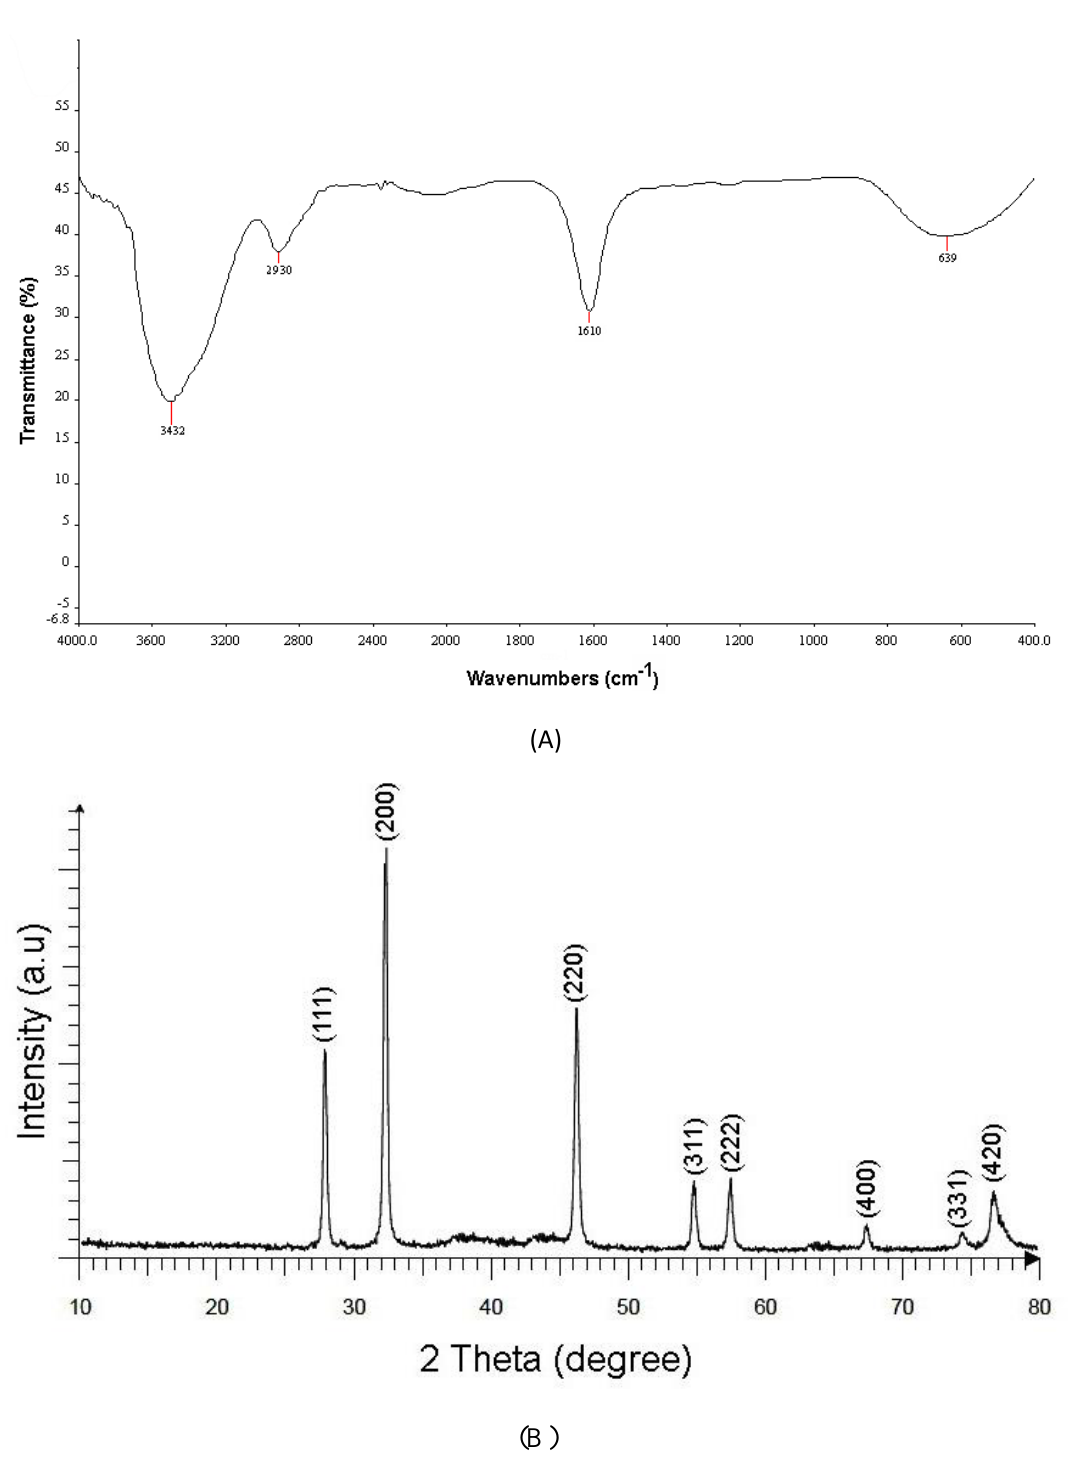
Figure 2. ( A ) The FTIR spectrum and ( B ) the XRD pattern of biosynthesized AgCl-NPs using aerial part extracts of the P. vulgaris plant.